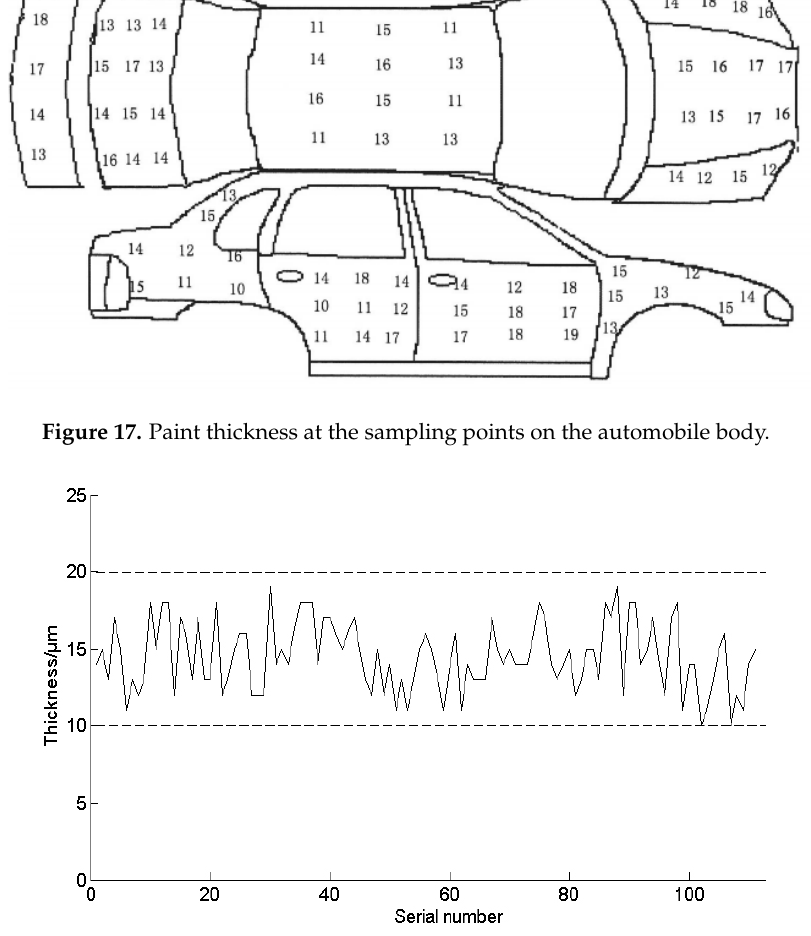
Figure 18. Curve of the coating thickness on the automobile body.